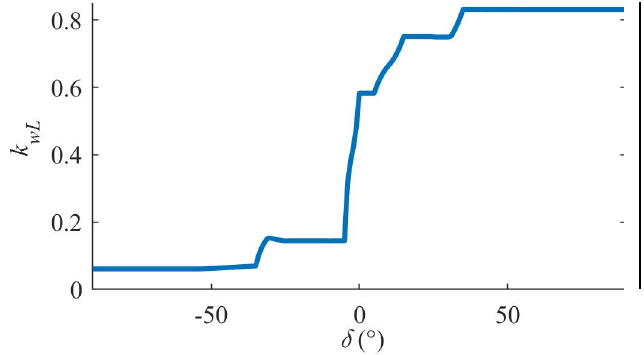
Figure 10. Cross-section of multiples of the maximum speed of the left engine along δ axis and at the distance of the mobile robot from the target position D = 0.5 m. In time domain it is defined by function (15)